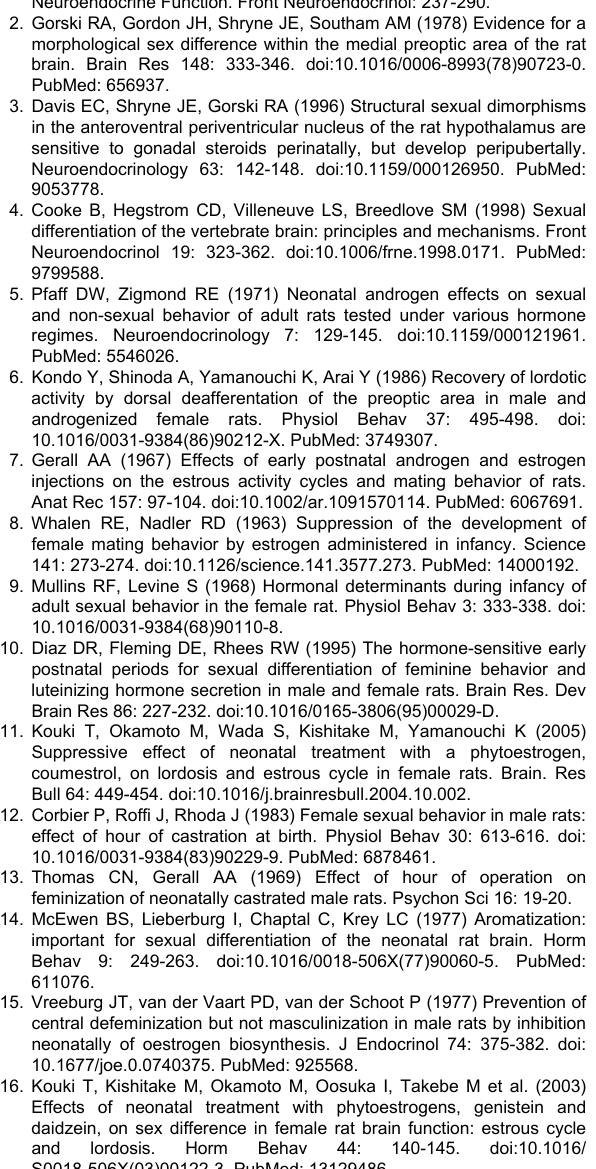
Figure S6. Transcriptional response to 24-h EB treatment in the hypothalamus of neonatal female mice. Heat map shows the hierarchical clustering of 240 Affymetrix probe ID either increased or suppressed by 2-fold or more in the whole subcutaneous EB injection compared with vehicle injection. See Figure S2 for details.